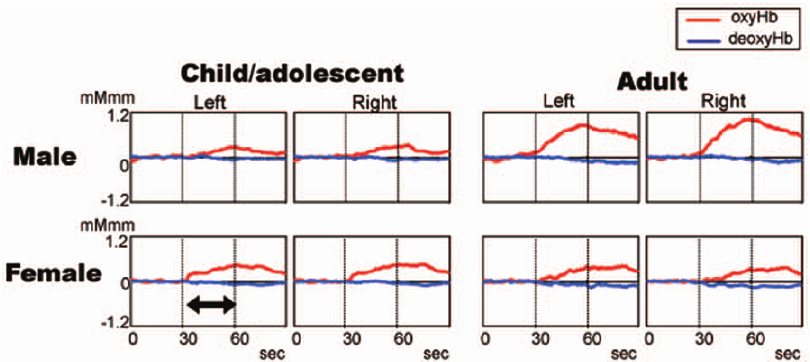
Figure 2. Grand average waveforms of D Hb during the letter fluency task. Upper: male, lower: female, right: adult group, left: child/ adolescent group. Line: red, oxyhemoglobin; blue, deoxyhemoglobin. The period of the activation task is between the two dotted lines.